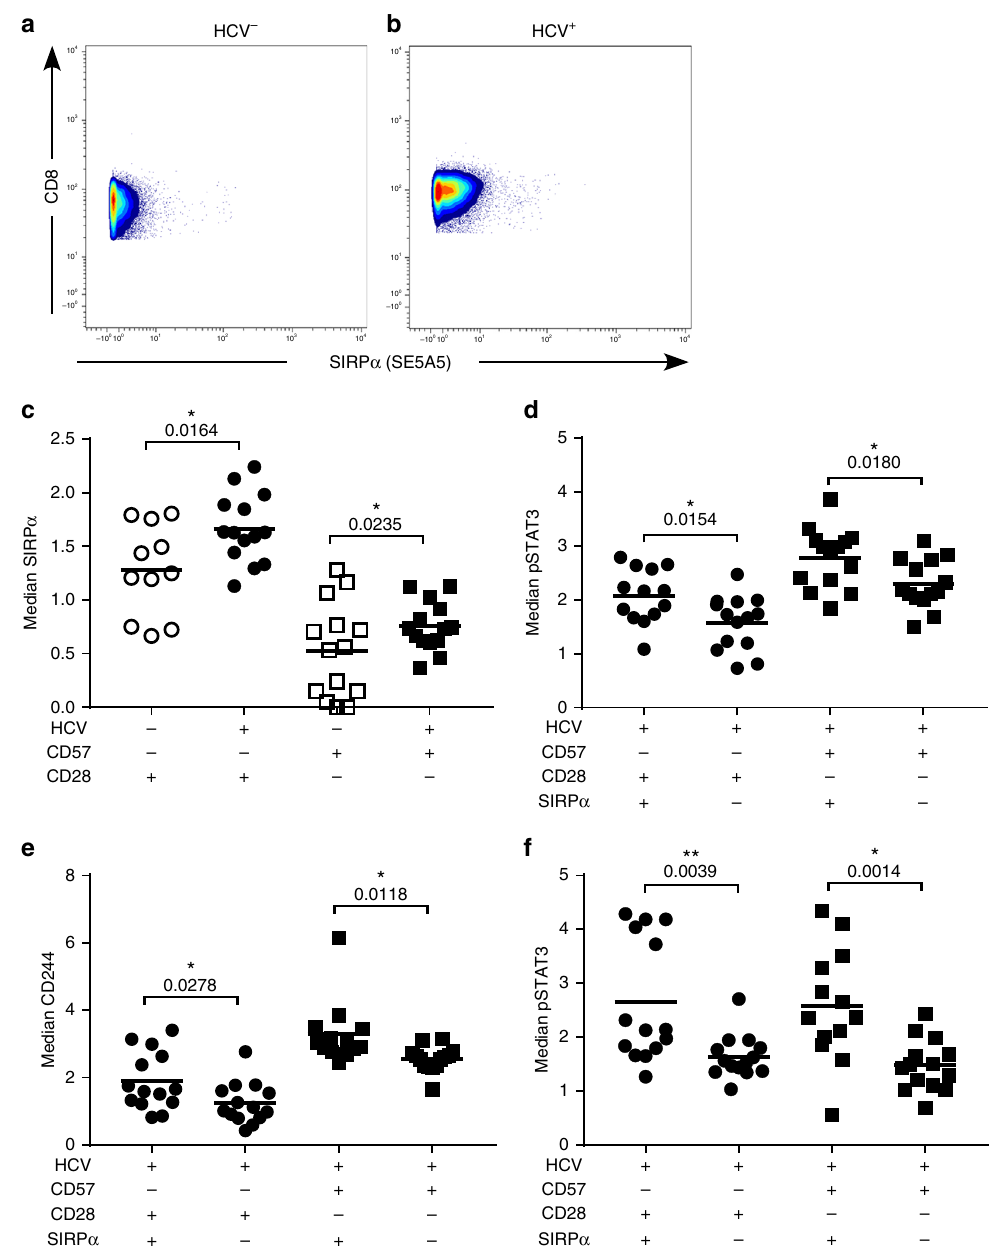
Fig. 8 Increased signal-regulatory protein alpha (SIRP α ) expression on CD8 + T cells from hepatitis C virus (HCV)-infected patients identi fi es a more activated phenotype. a Representative plots of CyTOF analysis of the median healthy donor and ( b ) the median HCV patient donor in regards to SIRP α expression levels. c CD8 + CD57 − CD28 + (circles) and CD8 + CD57 + CD28 − (squares) peripheral blood mononuclear cells from healthy controls (open symbols) and HCV-infected patients (closed symbols) were analyzed by CyTOF for SIRP α expression. For CyTOF analyses, fl uorescence intensity data are commonly transformed to arcsinh for analysis and display 81 . The SIRP α + and SIRP α − subsets of CD8 + CD57 − CD28 + (circles) and CD8 + CD57 + CD28 − (squares) from HCV-infected patients were further analyzed by CyTOF for the expression of ( d ) phosphorylated STAT3, ( e ) CD244, and ( f ) HLADR. Median expression levels (Arcsinh transformed) for each subset are represented by corresponding symbols, where each symbol represents an individual sample and the bar represents the mean. Differences between samples were statistically signi fi cant as shown by two-way unpaired t